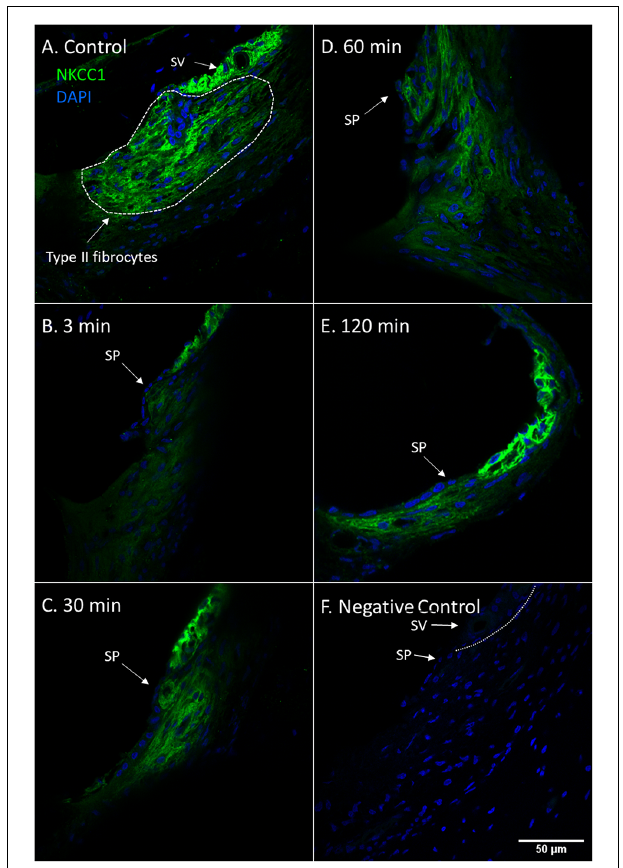
FIGURE 1 | NKCC1 in type II fibrocytes following furosemide injection. (A–F) Staining intensity of NKCC1 in the type II fibrocyte following administration of furosemide with DAPI staining of cell nuclei. Focus was set on the type II fibrocytes. Spiral prominence (SP); Stria vascularis (SV). (A) Normal NKCC1 staining in type II fibrocytes in a control guinea pig. (B) At 3 min after injection there was almost no staining of NKCC1 in the type II fibrocytes. (C) At 30 min the staining intensity of NKCC1 in the type II fibrocytes had returned to a low level. (D) At 60 min staining intensity was still decreased compared to control. (E) After 120 min the signal intensity had returned to near initial levels. (F) Negative control section with DAPI.